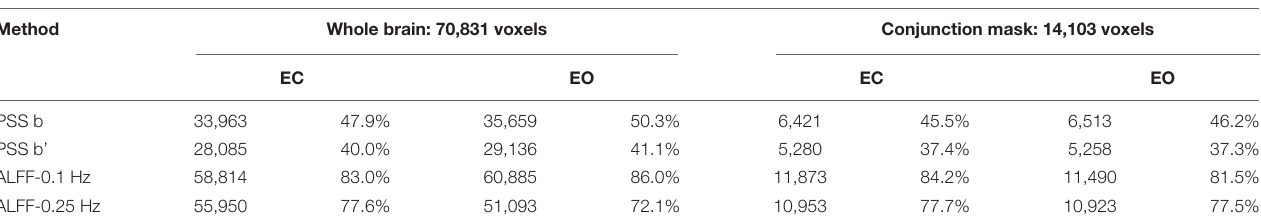
FIGURE 13 | ICC histograms of coefficient b and power-law slope b’ and ALFF under EC and EO conditions using individual Z-transformation. Panels (A,B) show the histograms of ICC values of EC (A) and EO (B) conditions from the entire brain. Panels (C,D) show the histograms of ICC values of EC (C) and EO (D) conditions from the conjunction mask of the voxels that survived GRF correction from EC–EO differences. TABLE 3 | Test–retest reliability with